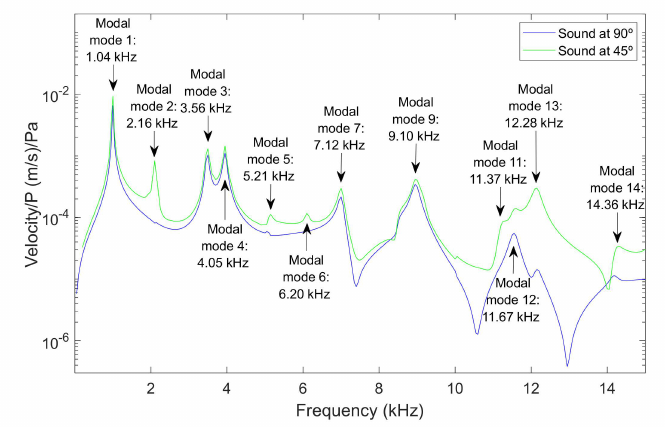
Figure 4. Point y = 0 x = radio/2 for a membrane of 40 µ m. Velocity magnitude at different positions of the source: (a) 90 ◦ and (b) 45 ◦